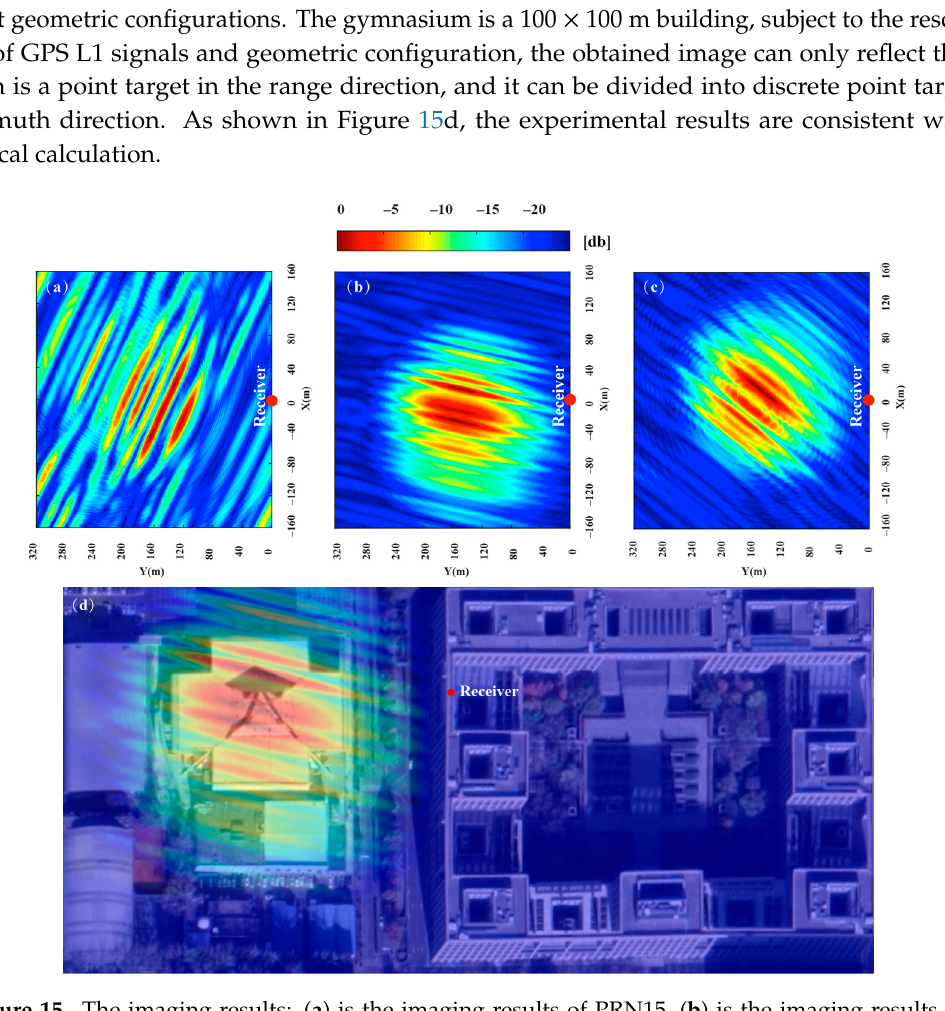
Figure 15. The imaging results: ( a ) is the imaging results of PRN15, ( b ) is the imaging results of PRN12, ( c ) is the imaging results of PRN 24, ( d ) is the imaging results of PRN12 and optical image (Google Map) matching.